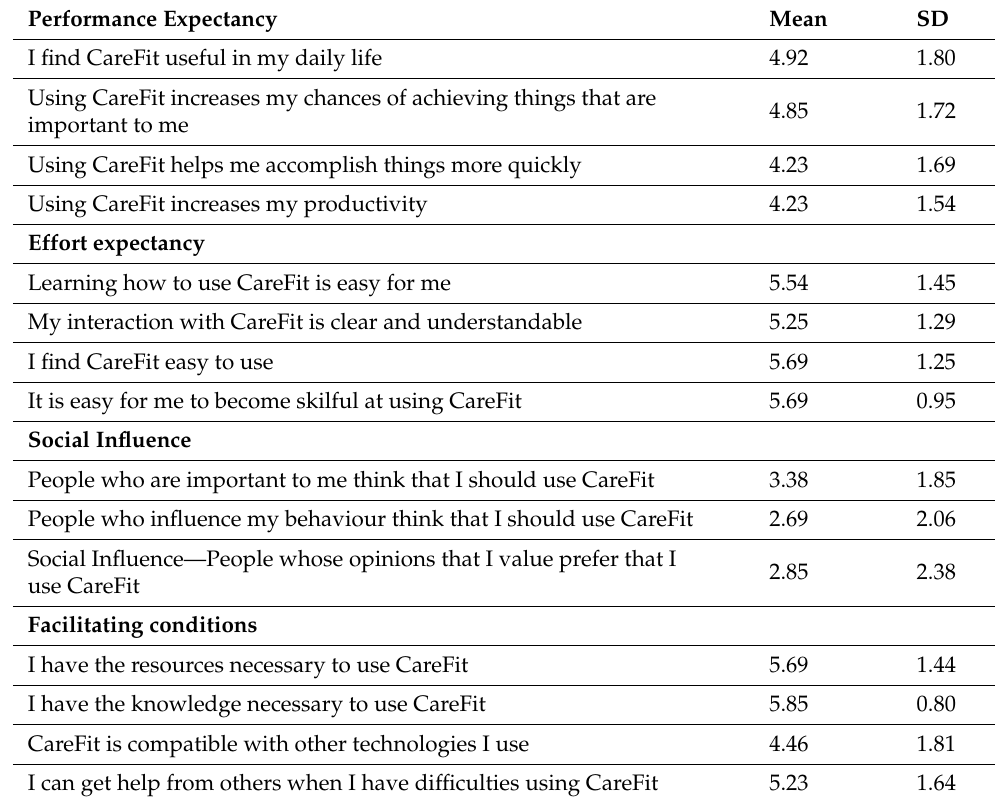
Table A2. Summary of participant responses from the Unified Theory of Acceptance and Use of Technology (UTAUT) 2 scale. Total number of respondents =